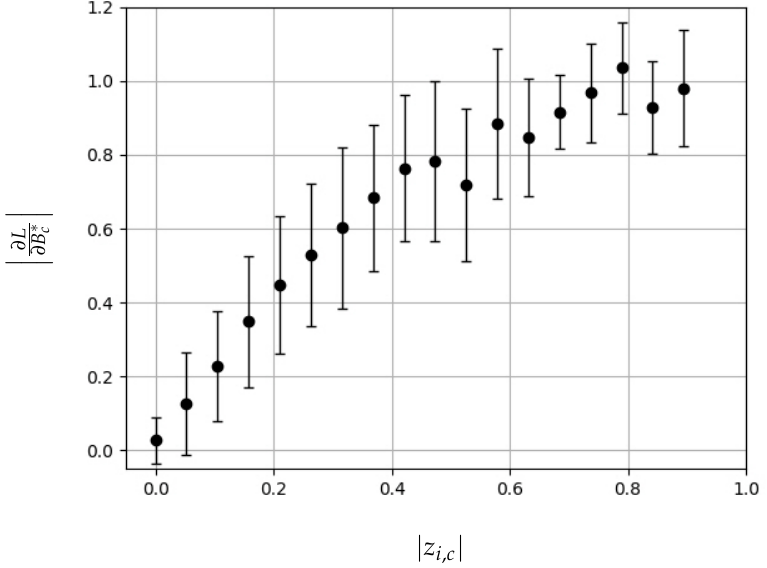
Figure 5. Histogram of the first gradients for the basis NDF blending weight . We uniformly spaced 20 bins in the domain of z i , c | | bars indicate the mean and the standard deviation of samples in each bin. Note that there shows no sample in the last two bins.